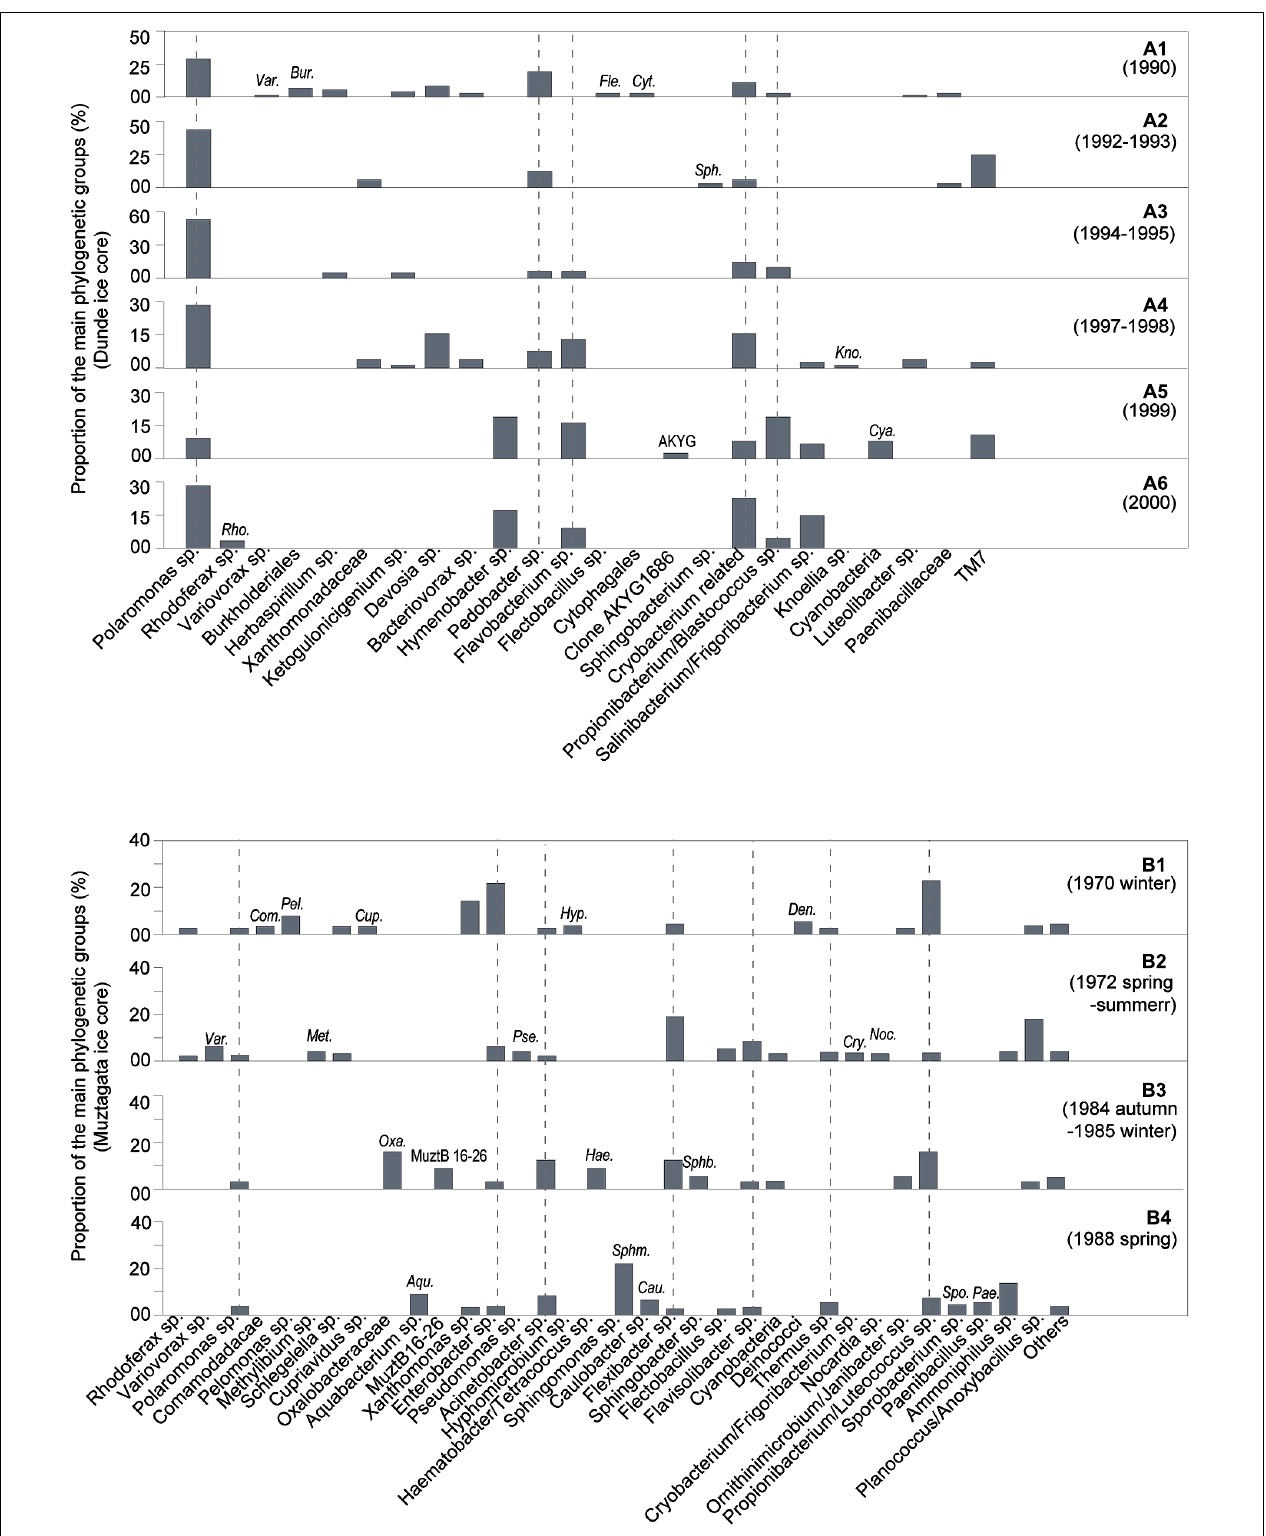
FIGURE 8 | Proportion of the main phylogenetic groups in the Dunde and Muztagata ice cores. (A1–A6) Dominant bacteria in six Dunde ice columns dated in the calendar year 1990, 1992–1993, 1994–1995, 1997–1998, 1999, and 2000, respectively. (B1–B4) Dominant bacteria in four Muztagata ice columns dated in 1970, 1972, 1984–1985, and 1988, respectively. Muztagata ice core dada was adapted from our previous report (An et al., 2010).